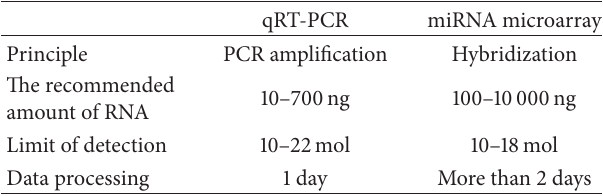
Table 5: Comparison of principal approaches for study of miRNA